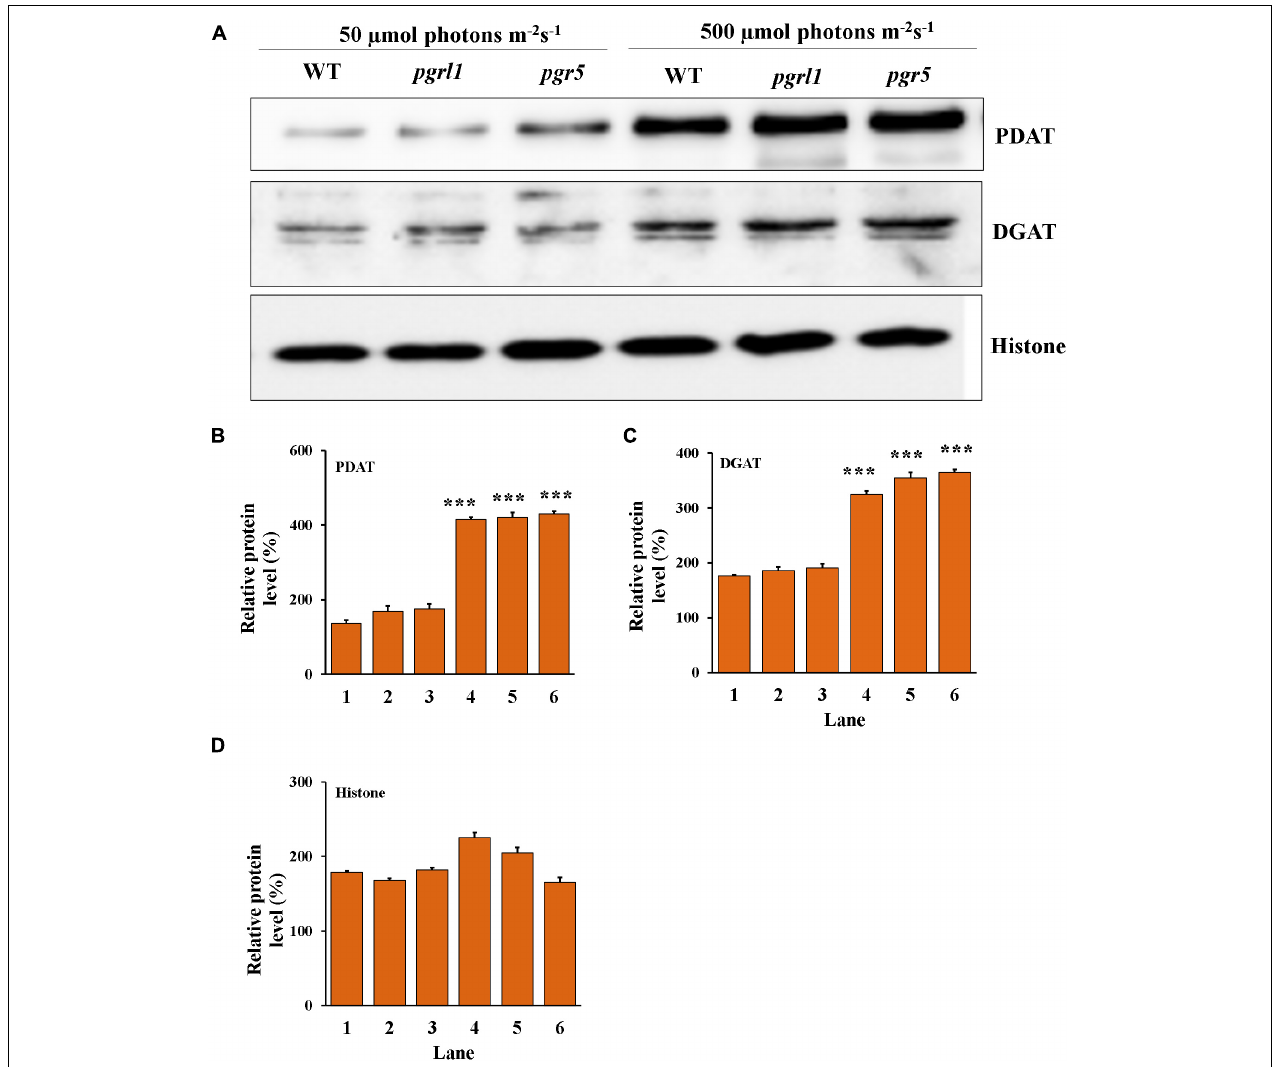
FIGURE 8 | Protein identification from western blot analysis. (A) The proteins were separated by denaturing gel electrophoresis, transferred to nitrocellulose membranes, and probed for the indicated proteins. Western blot analysis of Acyl-CoA: diacylglycerol acyltransferase (DGAT2A) and phospholipid diacylglycerol acyl-transference (PDAT1) evaluated from 3rd-day cells under the normal (50 µ mol photons m − 2 s − 1 ) and high (500 µ mol photons m − 2 s − 1 ) light condition, and each lane (5 µ g) protein were loaded on to 10% Bis-Tris gel in denaturing condition. Histone (H3) was used as a loading control. All the blots were in three independent times ( n = 3) and obtained similar results. (B) Quantification of the immunoblots of PDAT, (C) DGAT and (D) histone. Data are expressed as mean ± SD of 3 replicates. Statistical significance was analyzed using one-way ANOVA with Tukey test and p -value obtained are indicated (*** p <